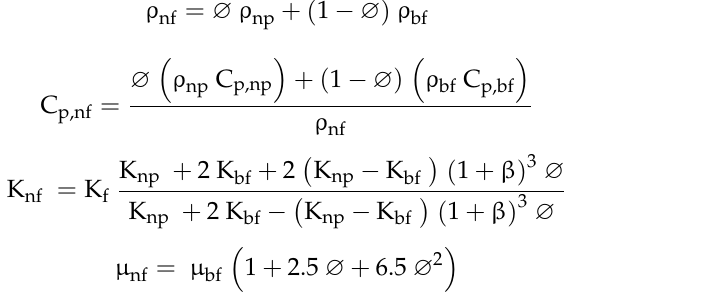
Table 3. Thermal properties of the examined nanoparticles and base fluid [41,42]. Thermal Conductivity Density Specific Heat (J/kg K) Nanoparticle (W/m K) (kg/m 3 ) Graphene 2160 710 5000 Silver 10,500 235 429 Ethylene Glycol 1126 2345